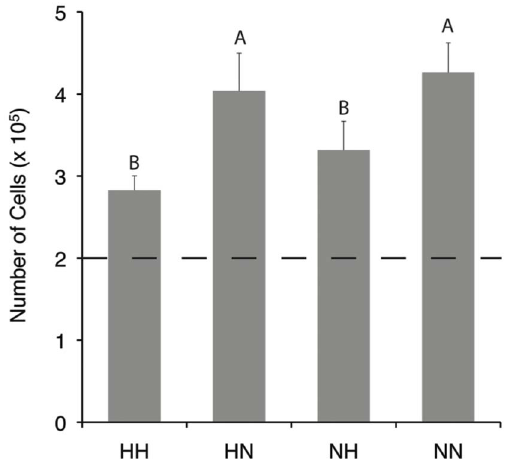
Figure 2. Hypoxia limits proliferation during 3D culture. Cells were seeded at 2 6 10 5 per micromass (dashed line). Data are mean 6 S.D. Groups not connected by letters are significantly different with p ,